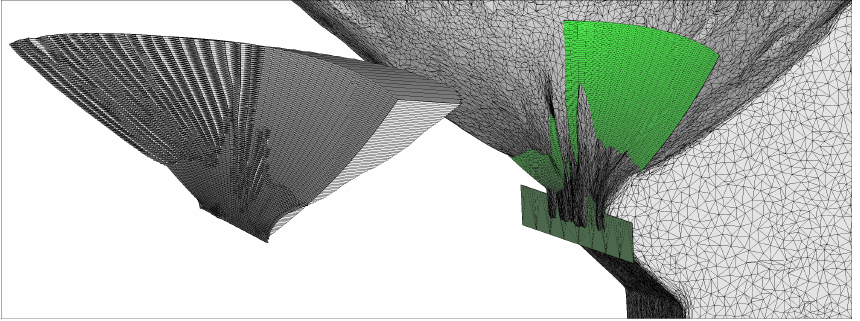
Figure 9. Discretized volume between the CRACKTRACER3D crack surface (in green) and the experimental